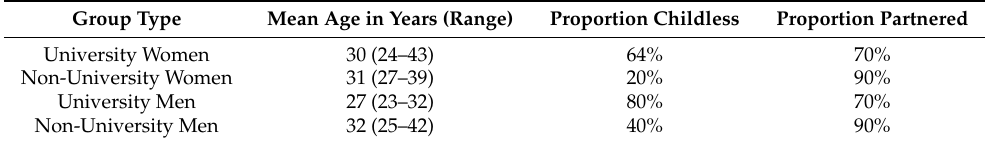
Table 1. Participant